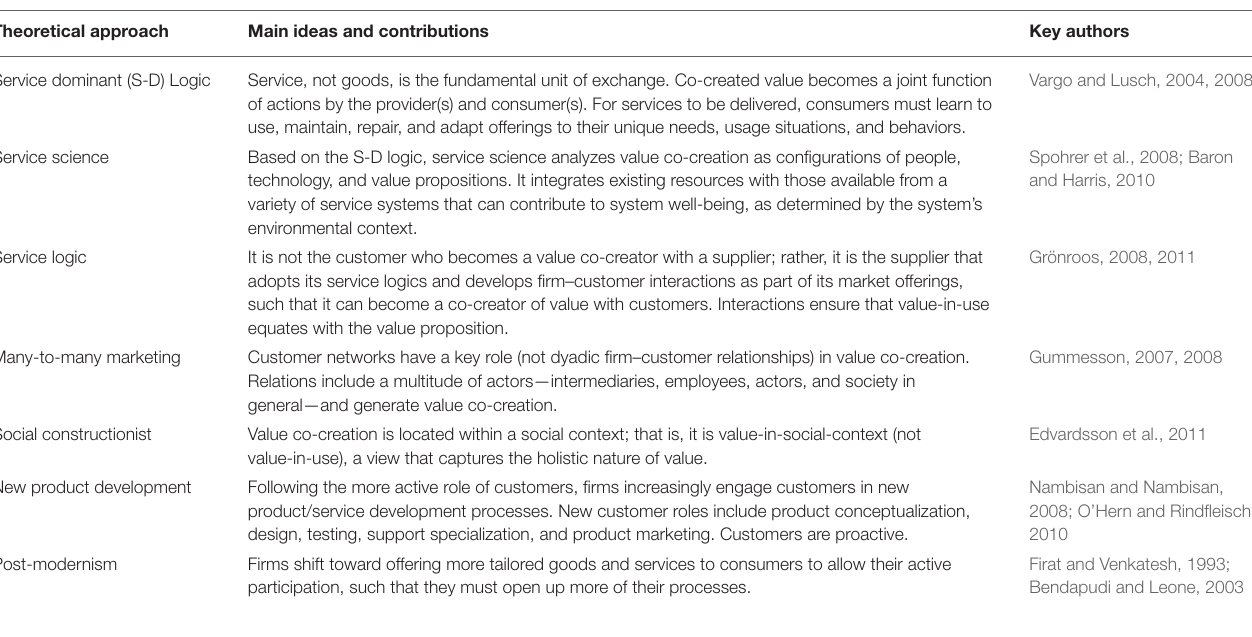
TABLE 1 | Theoretical approaches to value co-creation